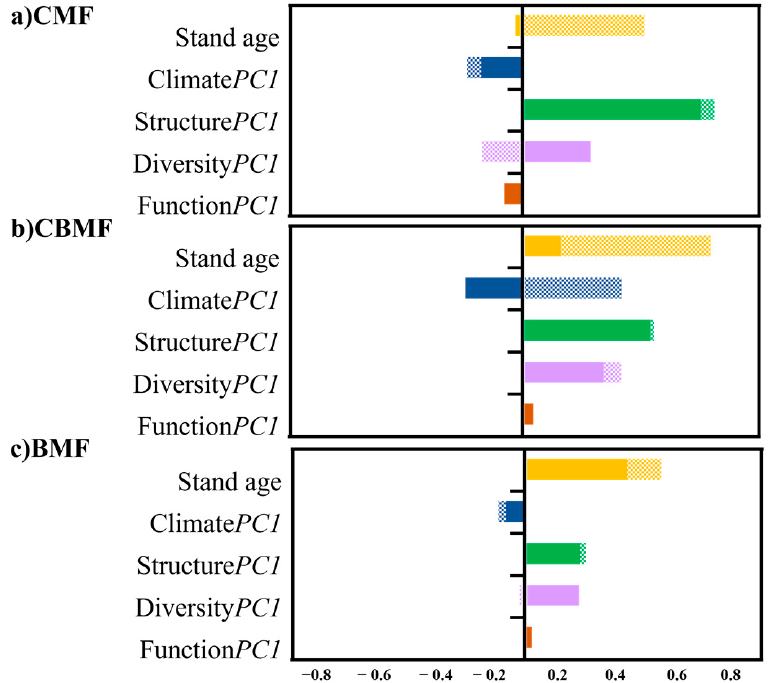
Figure 7. Beta coefficients of stand age, climate PC1 , structure PC1 , diversity PC1 , and function PC1 on aboveground wood carbon. CMF, CBMF, and BMF represent the coniferous mixed forests, coniferous–broadleaf mixed forests, and broadleaf mixed forests, respectively. PC1 refers to the first principal component of the results of principal component analysis. Filled and dotted bars indicate the direct and indirect effects of abiotic and biotic factors on aboveground wood carbon, respec- tively.